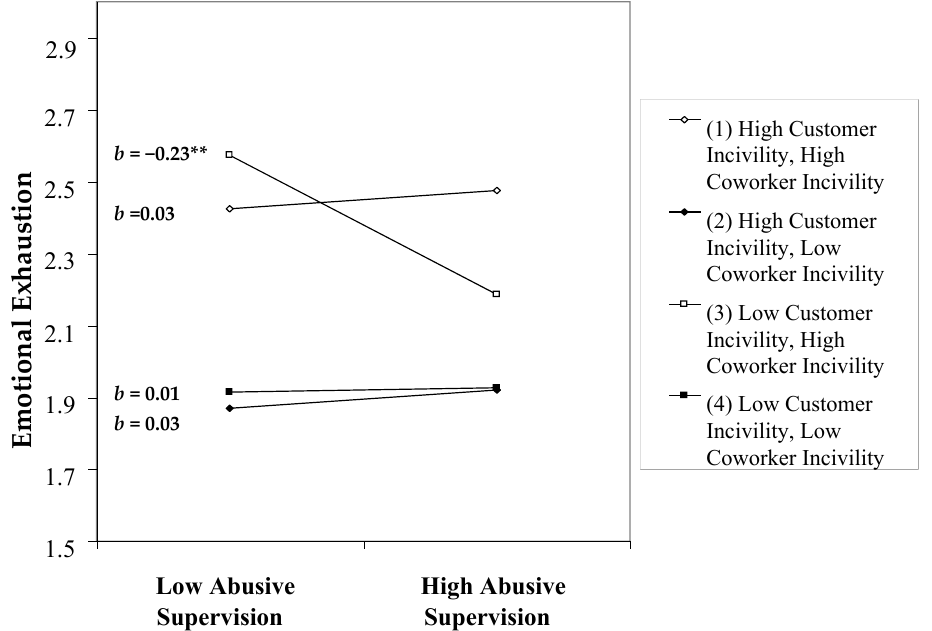
Figure 4. Simple plot analysis for the three-way interaction effect of abusive supervision, coworker incivility, and customer incivility on emotional exhaustion. ** p < 0.01 . b = unstandardized coeffi- cient.